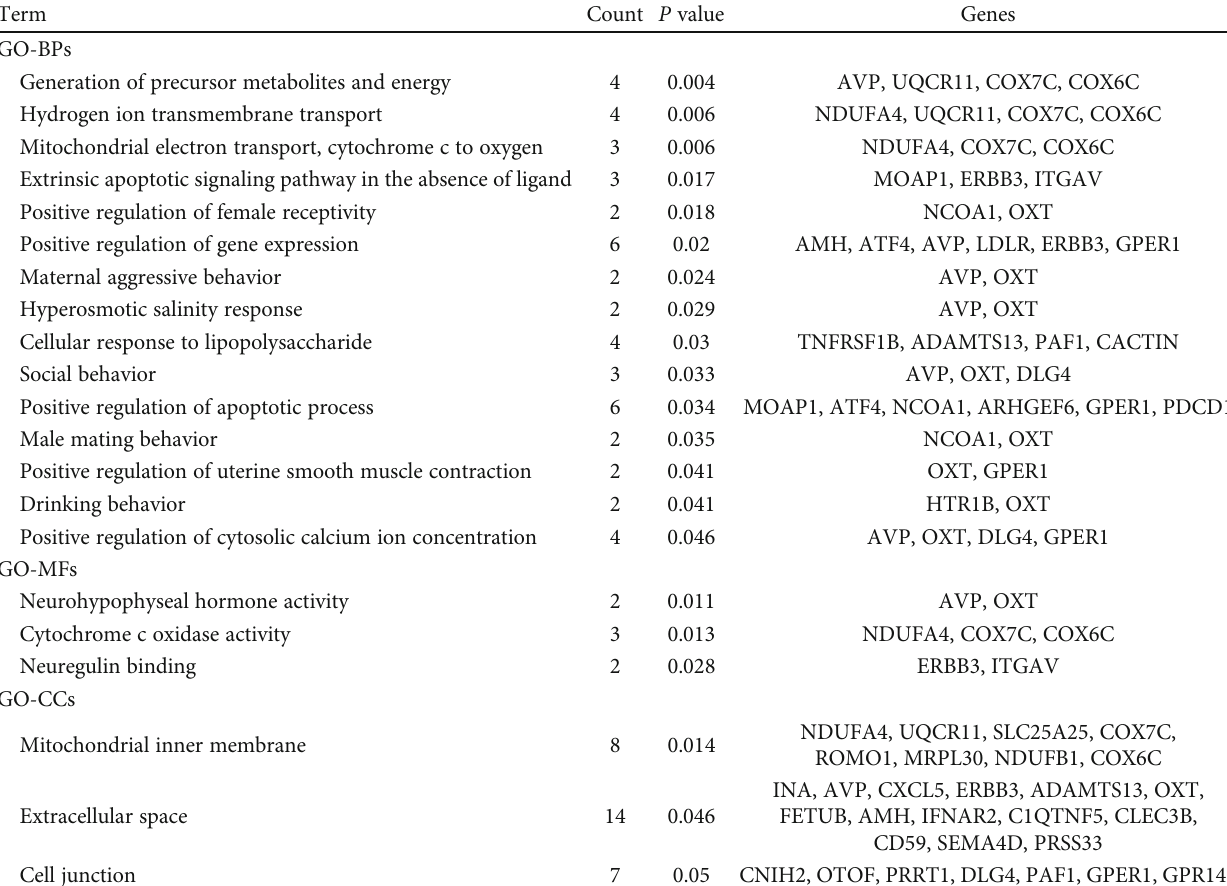
Table 1: The results of Gene Ontology (GO) of DEGs ranked by P value.